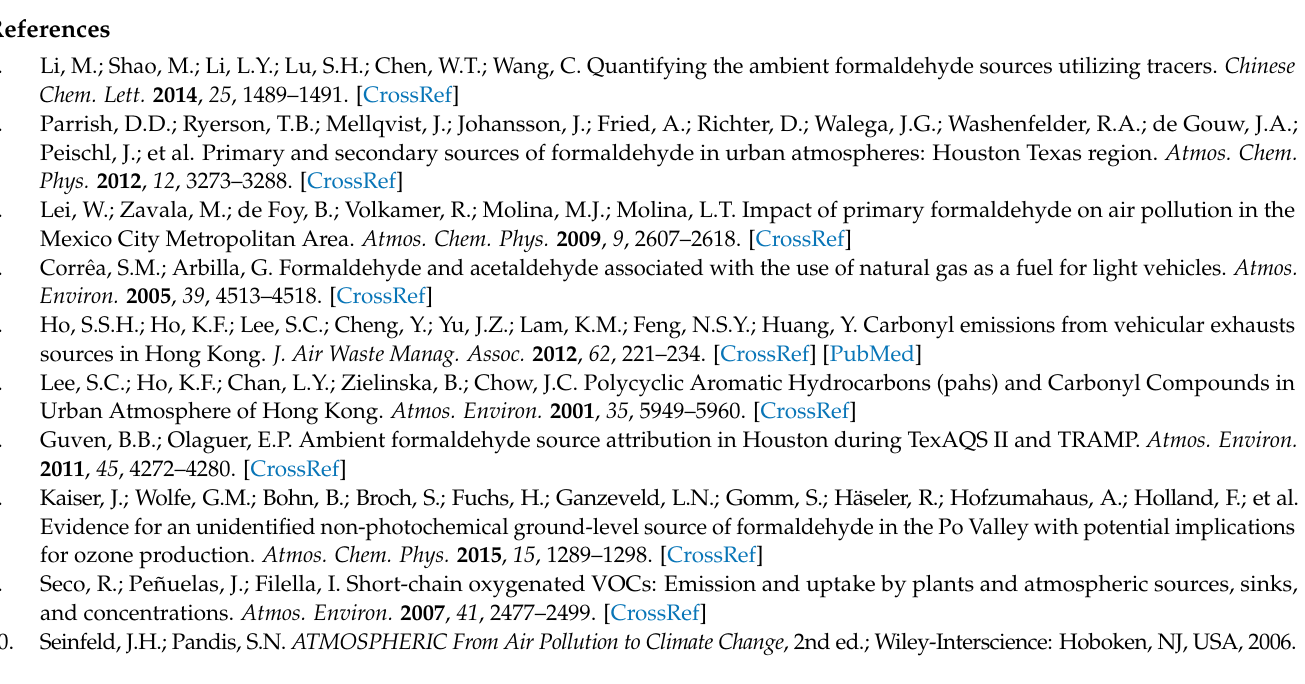
Table S4: Analytical values obtained by Lab. APPA Trento and Lab. RSE using different methods during second campaign; Figure S1: Comparison between the values measured during the first campaign; Figure S2: Comparison between the values measured during the second